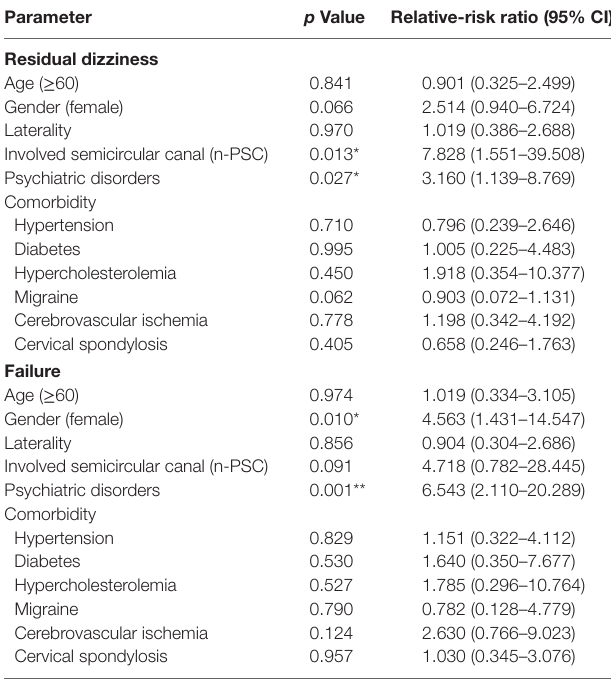
TaBle 3 | Multinomial logistical regression analysis of one-week treatment outcome of BPPV. Parameter p